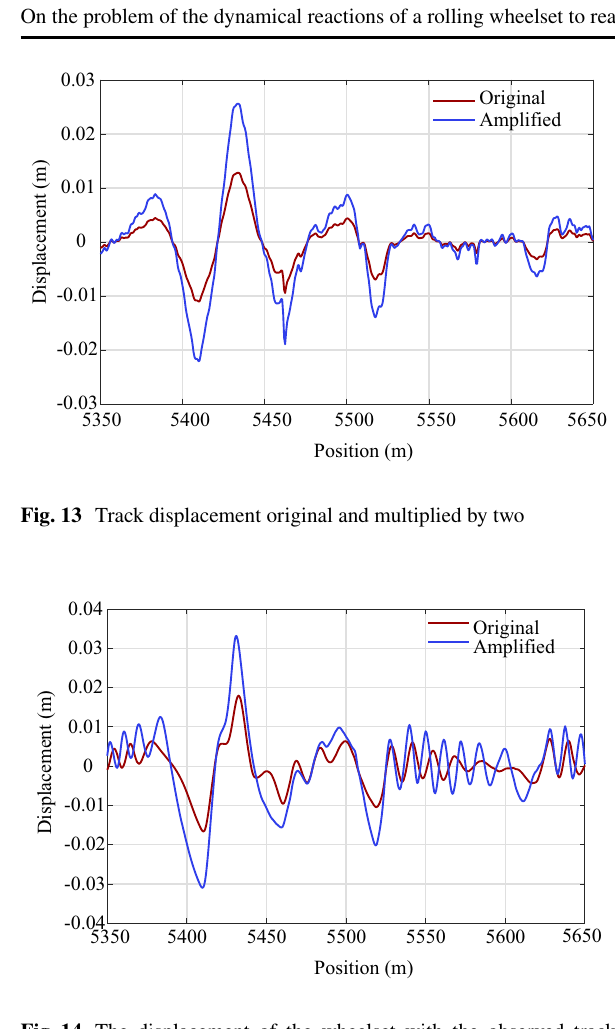
Fig. 14 The displacement of the wheelset with the observed track displacements and when the observed track displacements are mul- tiplied by two